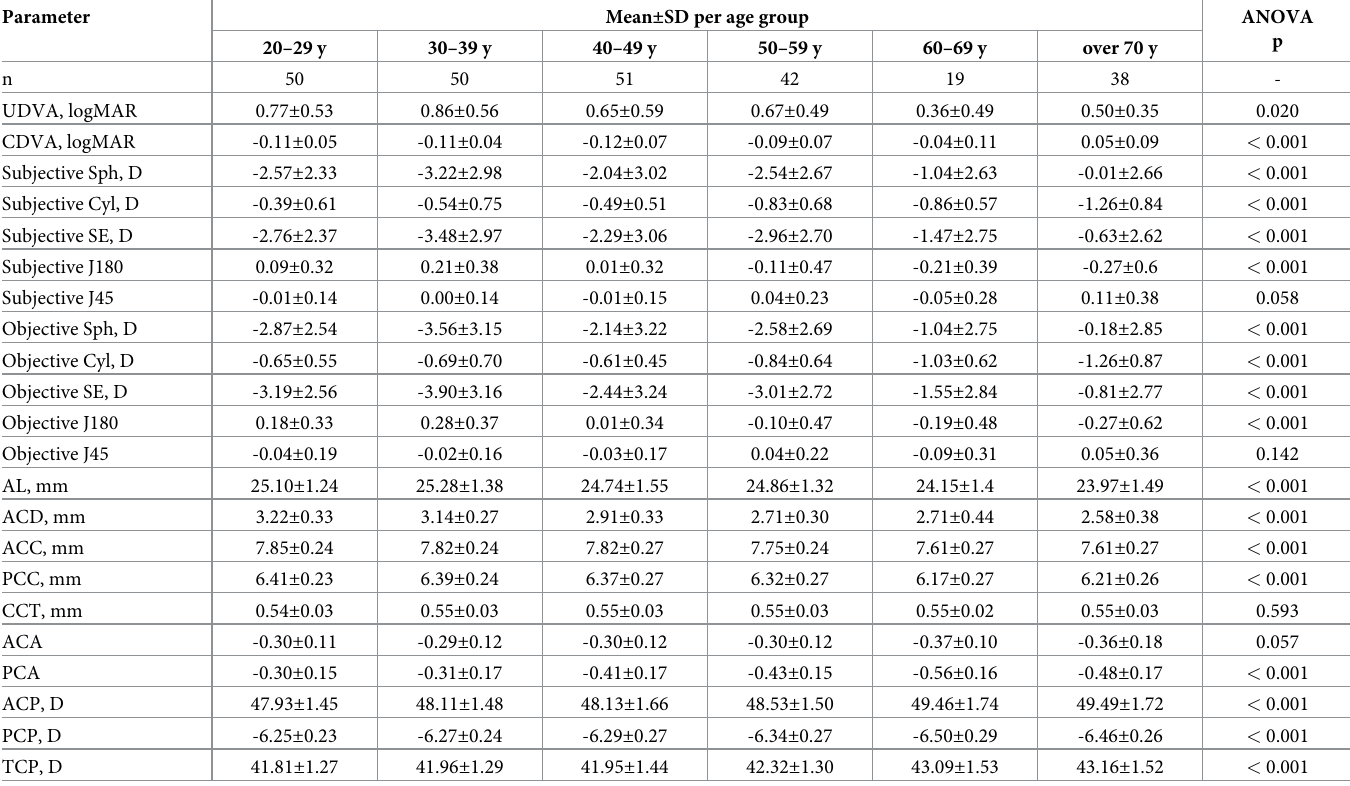
Table 3. Comparison between age groups in ocular